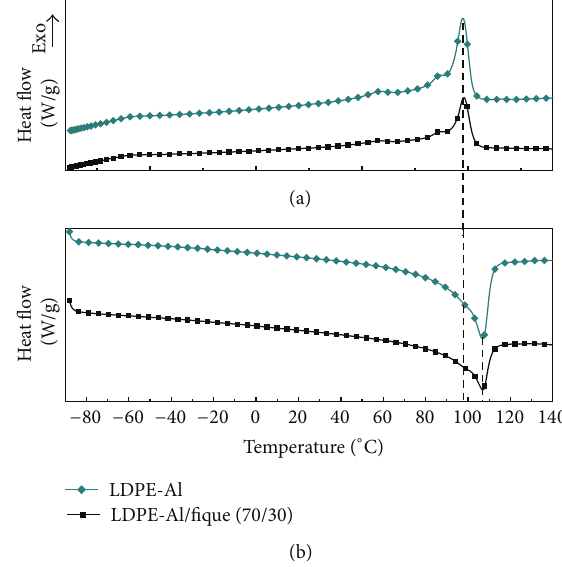
Figure 10: Heat flow versus temperature for LDPE-Al and 30% fique fiber compound: (a) cooling and (b) second